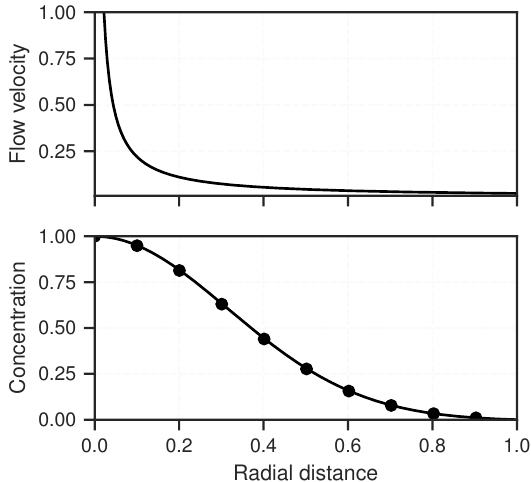
Figure A1. (top) The decline of the flow velocity along the r-axis due to the diverging flow; and (bottom) the comparison of the analytical and numerical solutions for solving Equation (A7). The solid line and dots represents the analytical and numerical solution,